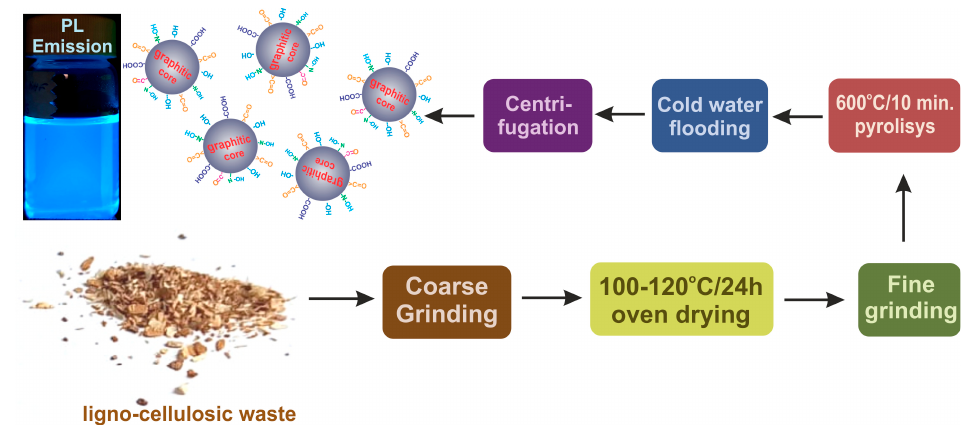
Figure 1. Preparation scheme of the photo emissive CDs from forestry ligno-cellulosic waste.